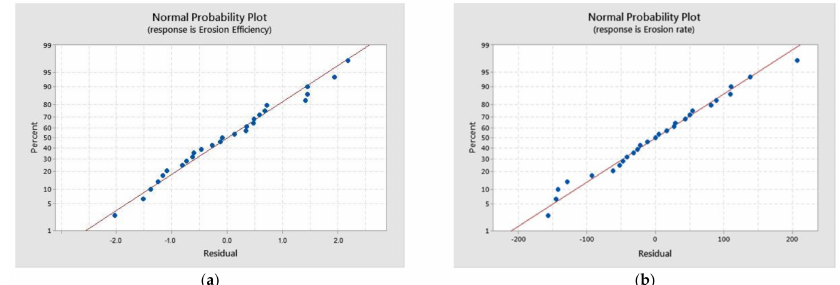
Figure 4. Standard probability plot for ( a ) Erosion efficiency and ( b ) Erosion